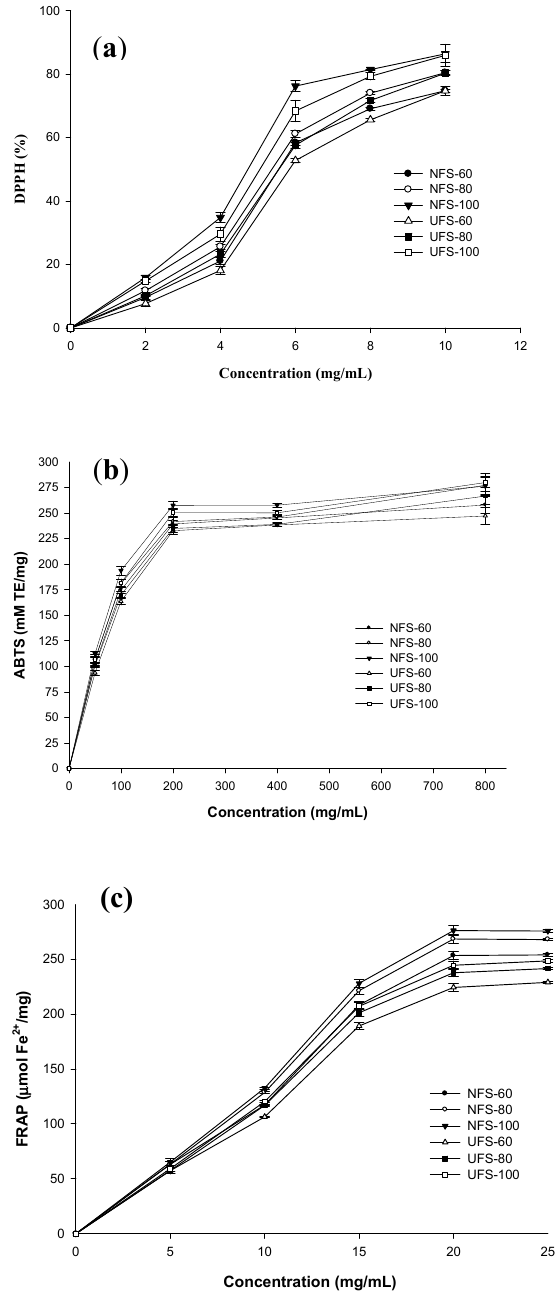
Figure 3. Antioxidant activity of palmyra palm syrups at different concentrations: ( a ) DPPH radical scavenging activity, ( b ) ABTS radical scavenging activity, and ( c ) FRAP. Data are mean ± SD from triplicate experiments.